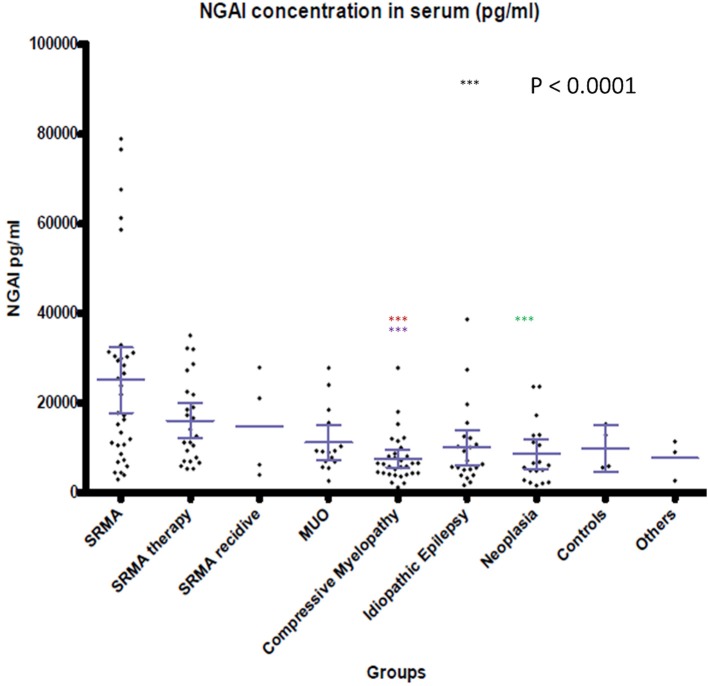
NGAL concentrations in serum of the different groups. Boxes contain values from the first to the third quartile; lines inside the boxes indicate median values; end of vertical lines show minimum and maximum values; dots represent outliers. Red asterisks (***) represent groups differing significantly (p < 0.0001) from acute SRMA group. Lilac arterisks (***) represent groups differing significantly from SRMA therapy group. Green arterisks (***) indicate groups differing significantly from SRMA acute group only in Dunn's post hoc test. NGAL, neutrophil gelatinase-associated lipocalin; SRMA, steroid-responsive meningitis-arteriitis; CSF, cerebrospinal fluid; MUO, meningoencephalitis of unknown origin; IE, idiopathic epilepsy; “SRMA therapy” consisted of dogs under treatment without clinical signs, “SRMA recidive” consisted of dogs with relapse of clinical signs, “Myelopathy” group consisted of dogs with intervertebral disc herniation or compressive spondylomyelopathy, “Neoplasia” included dogs with primary and secondary brain tumors, “Controls” included patients without neurological disorders (healthy and orthopedic), “Others” included various neurological diseases (bacterial meningoencephalitis, idiopathic vestibular syndrome, behavioral abnormalities).